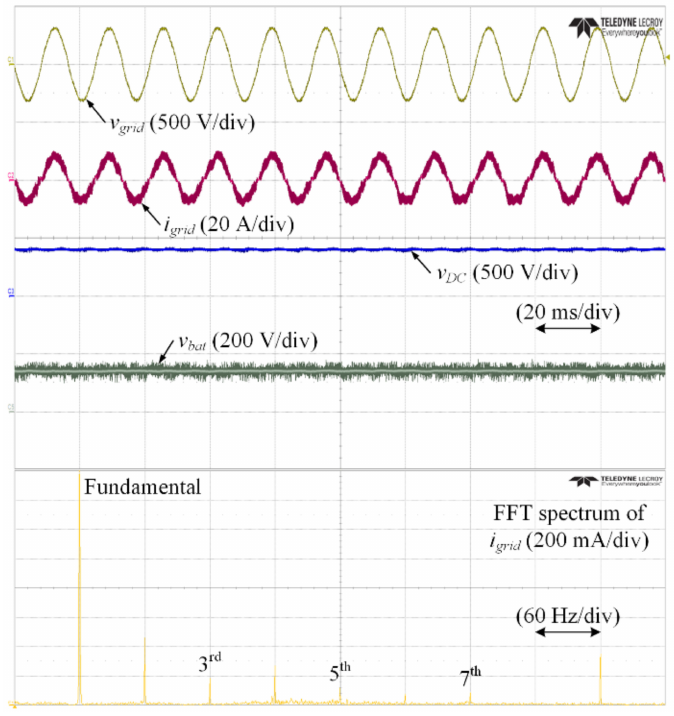
Figure 16. Experimental results of integrated OBC with proposed reduction method of third-order and sixth-order harmonic components.